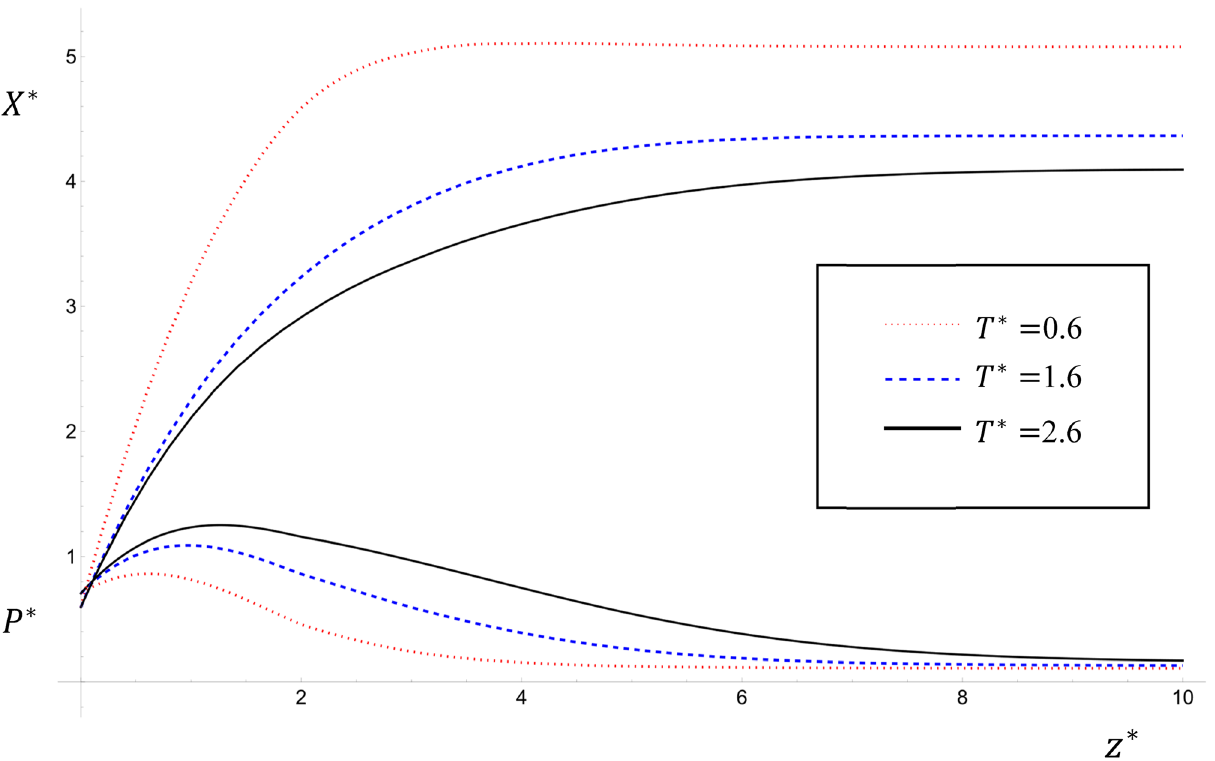
0.6, 1.6, 2.6 and U =